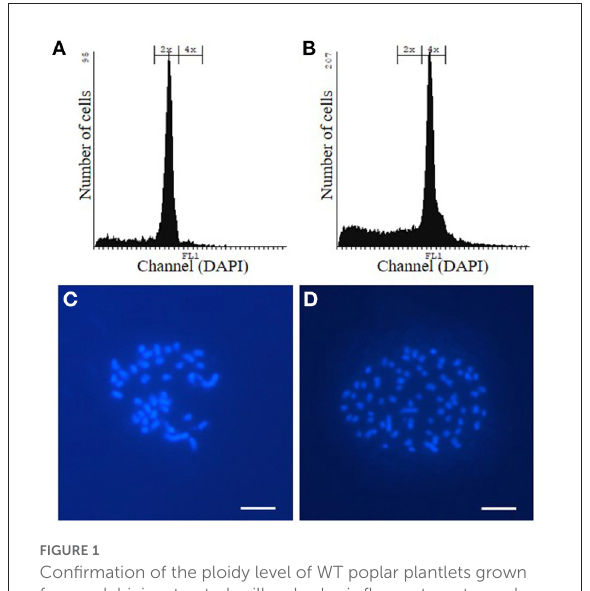
FIGURE1 Confirmation of the ploidy level of WT poplar plantlets grown from colchicine-treated axillary buds via flow cytometry and chromosome spreads. (A, C) WT diploid poplar. (B, D) WT tetraploid poplar. Pictures are representative for the different independent tetraploid lines. The same way, the ploidy level of hpCAD di- and tetraploid poplar was verified (Supplementary Figure 2). Scale bars = 5 µ